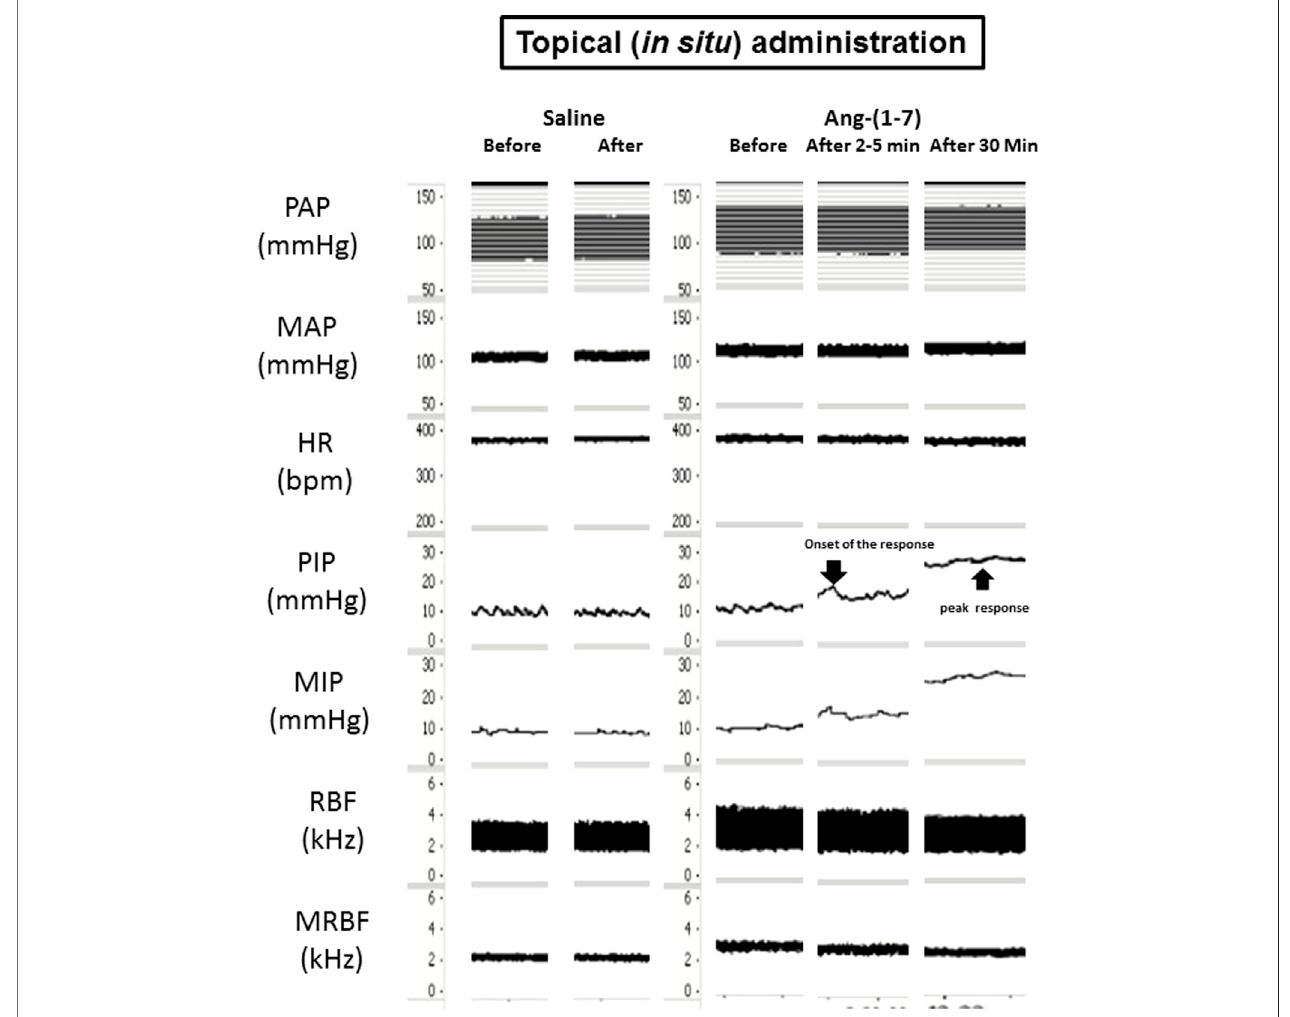
FIGURE4| Tracingsshowingthebaselinepulsatilearterialpressure(PAP,mmHg),meanarterialpressure(MAP,mmHg),heartrate(HR,bpm),pulsatileintravesical pressure(PIP,mmHg),meanintravesicalpressure(MIP,mmHg),renalblood fl ow(RBF,kHz)andmeanrenalblood fl ow(MRBF,kHz)andtheresponsesyieldedby insitu administration of angiotensin-(1 – 7) (100 ng/ml, 0.1 ml per rat) or saline (0.1 ml) onto the urinary bladder.